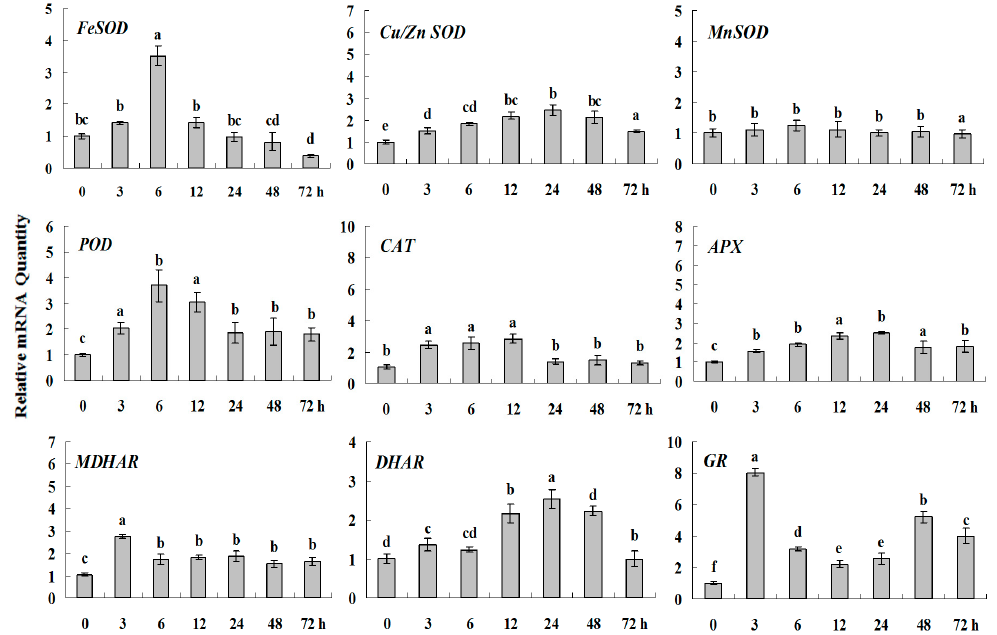
Figure 7. Quantitative real-time RT-PCR was used to analyze of ROS-scavenging enzyme genes expression treatment with ABA and normalized to β - actin . White clover leaves were sampled after 0, 3, 6, 12, 24, 48 and 72 h treatment. Data represent means of three replicates. Error bars representing standard errors and the different letters above the bars represent significant difference ( p < 0.05).